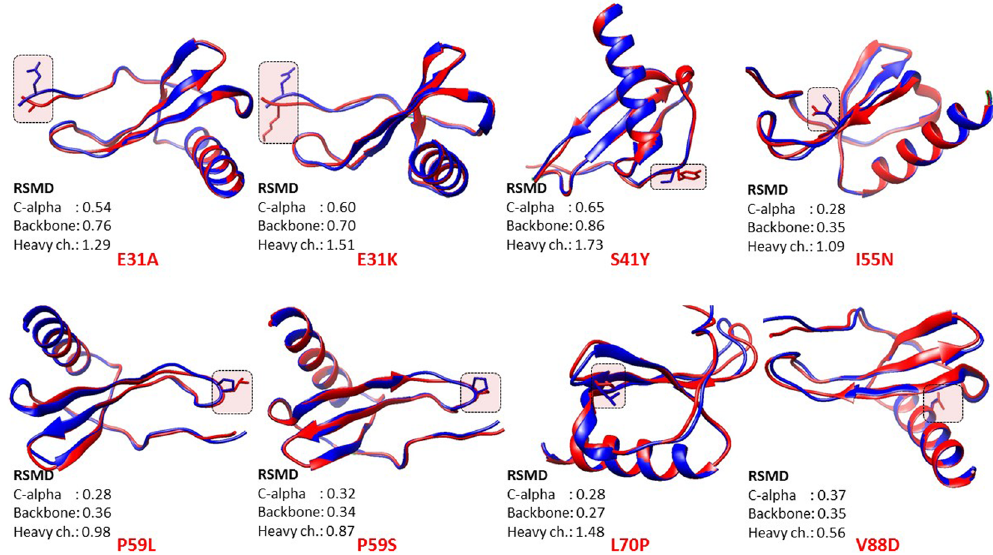
Figure 6. Structural superimposition of modelled mutant proteins (in pink) on the wild type IL-8 protein (in peacock blue) using